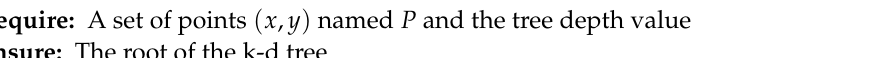
Algorithm 1 k-d tree